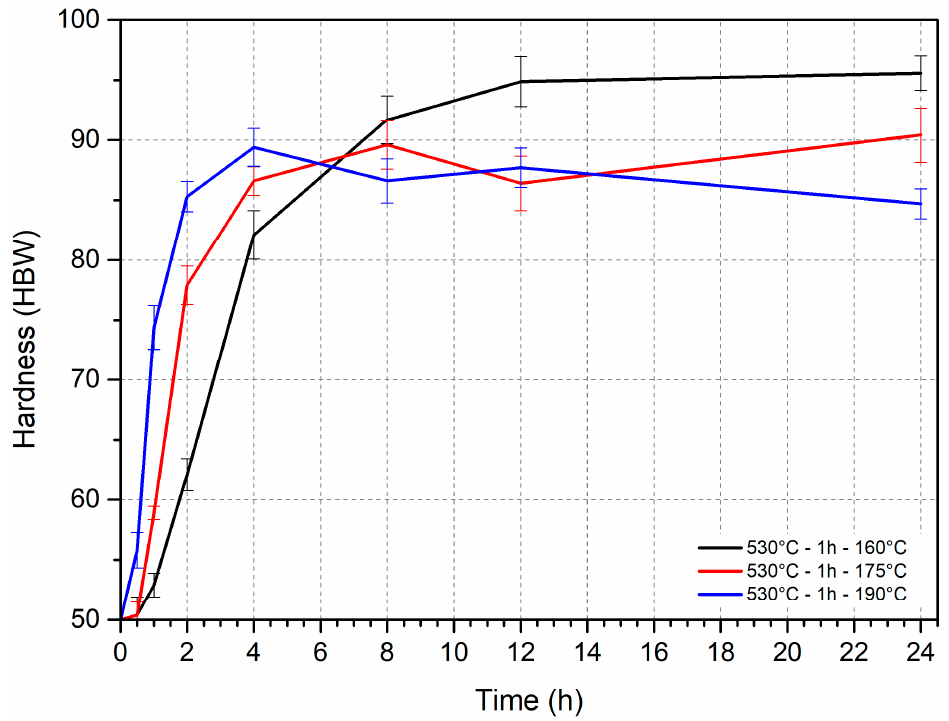
Figure 2. Measured hardness values (HBW) for samples after solution annealing and after artificial aging at 160 °C, 175 °C and 190 °C.